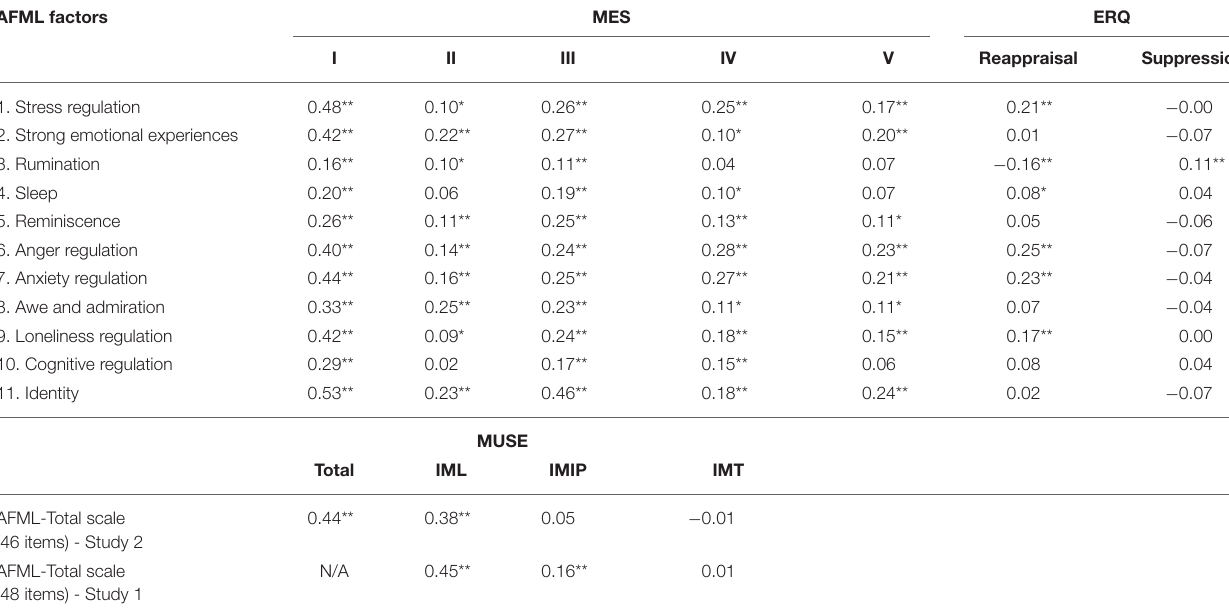
TABLE 7 | Bivariate correlations between the AFML subscales and the music engagement subscales of the MUSE and ERQ. AFML